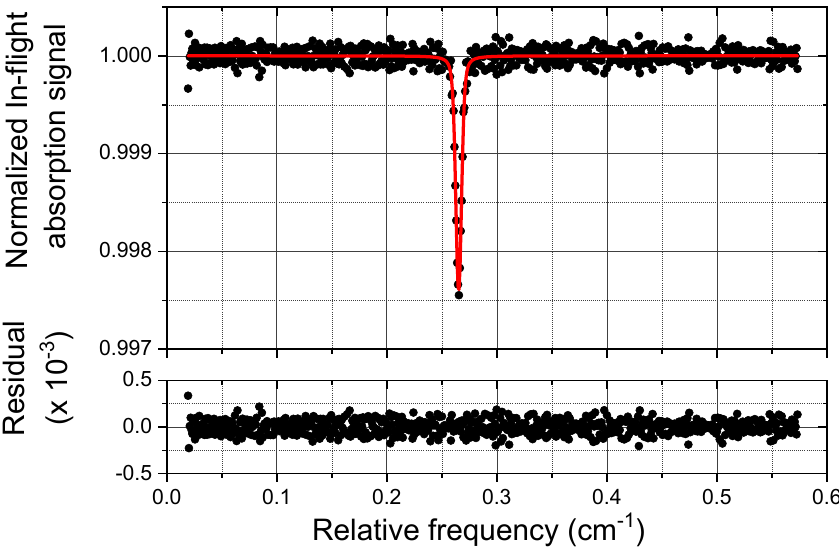
Figure 9. Example of a typical in-flight CO (36 ± 1 ppbV) normalized absorption spectrum (scatter) and Voigt fit results (red line). The residual of the fitting procedure is shown in the bottom graph. The acquisition time is 1 s. The measurement was carried out during the flight on the 29th July 2017 at an altitude of 19 km and at a temperature of 281.8